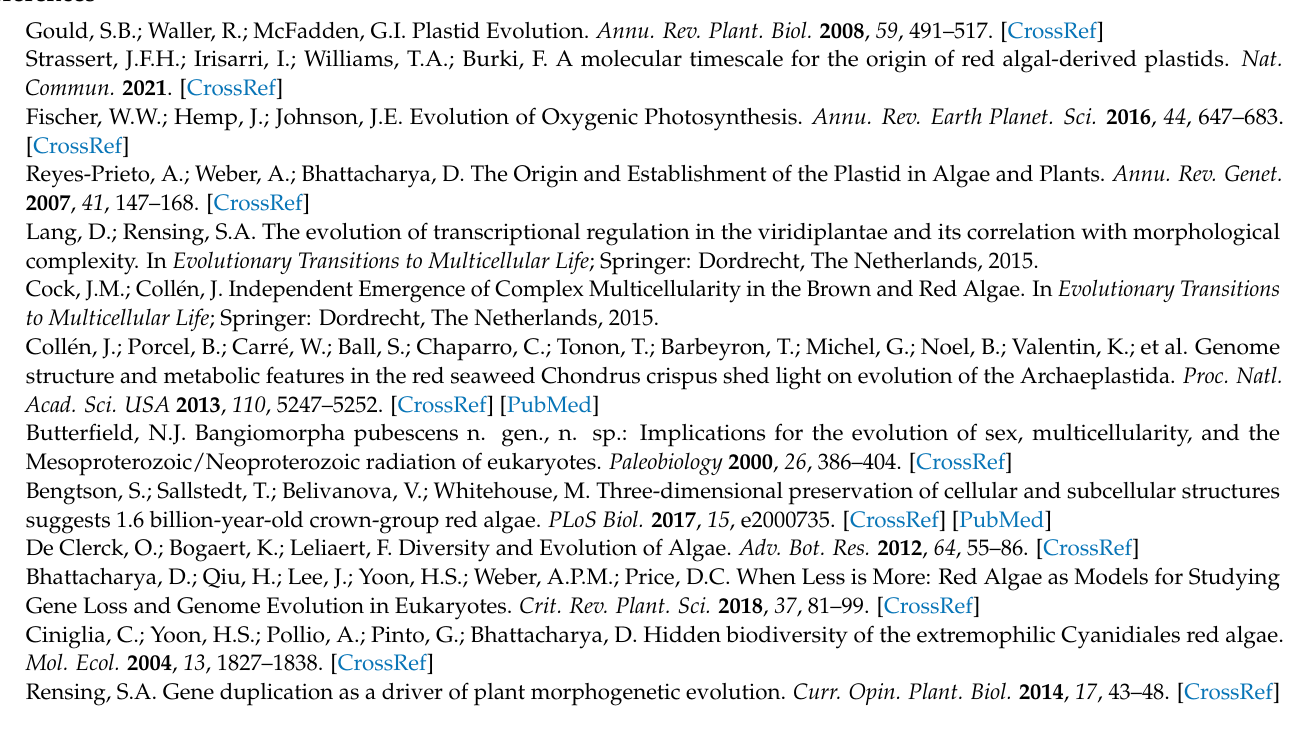
C2H2 family, Figure S2: Neighbor joining tree of the C2H2 family, Figure S3: Neighbor joining tree of the HSF family, Figure S4: Bayesian inference tree of the HSF family, File S1: Alignments and adjusted profile HMMs of selected